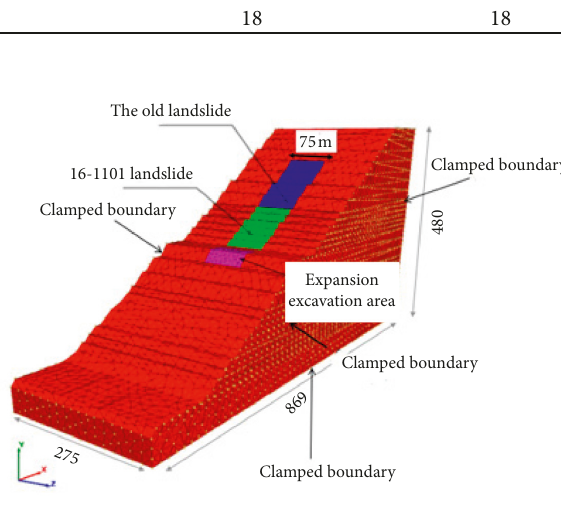
Figure 22: Model building and